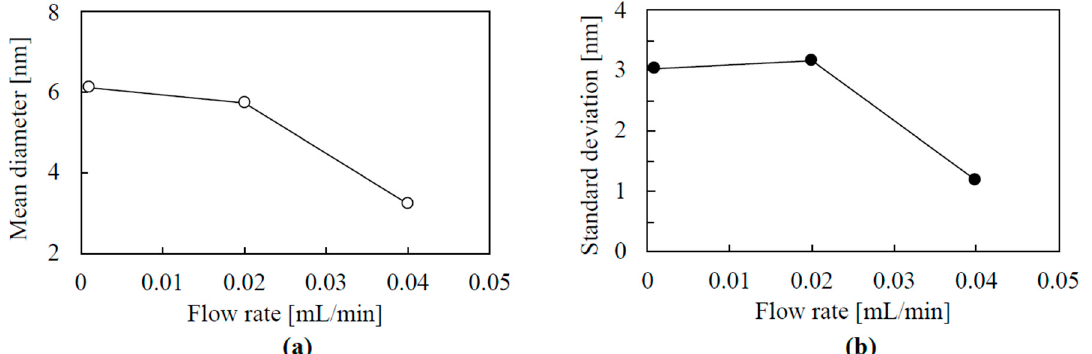
Figure 6. ( a ) Mean diameter and ( b ) standard deviation calculated from TEM images of CuNPs as a function of the flow